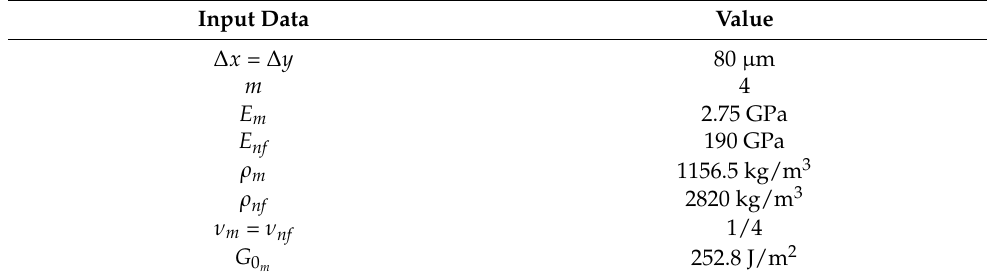
Table 7. Input data for the calibration